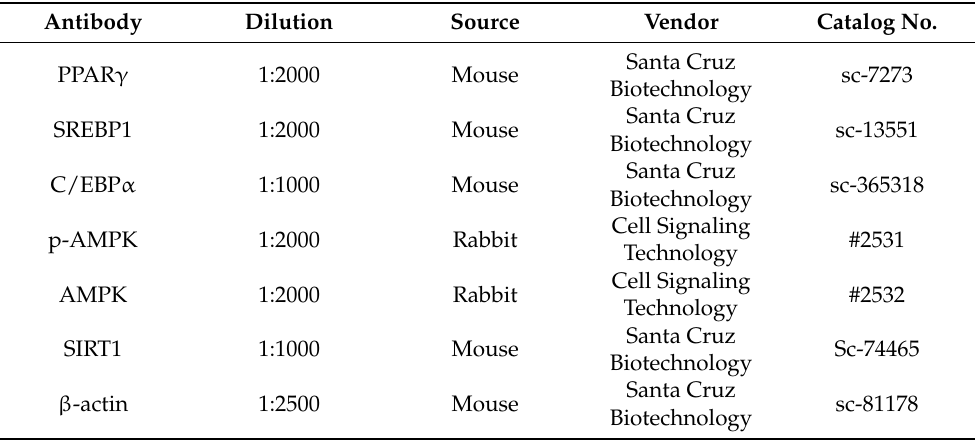
Table 2. Antibodies for Western